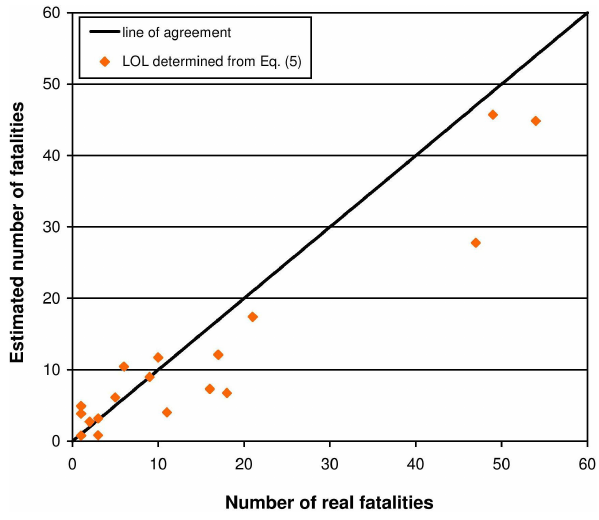
Figure 1. The degree of agreement between the real and calculated number of